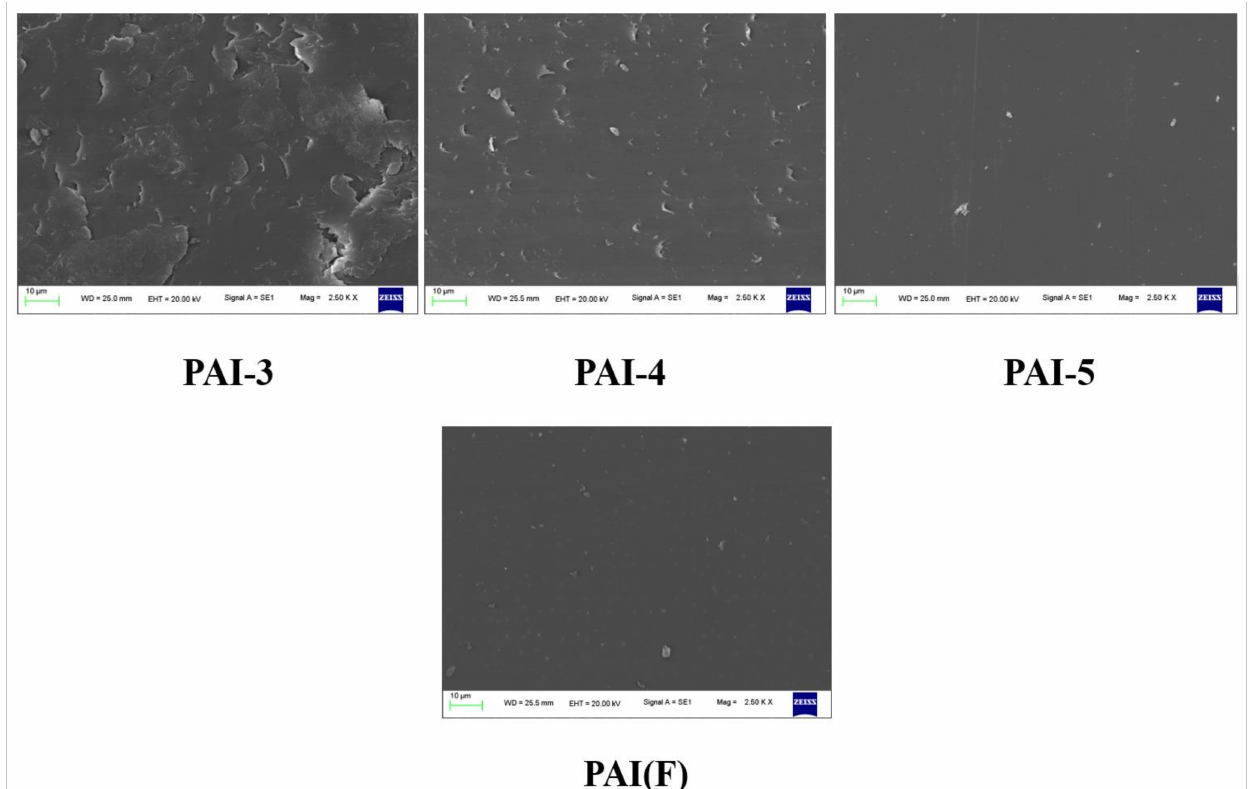
Figure 6. SEM diagram of friction surface of synthetic PAI materials.